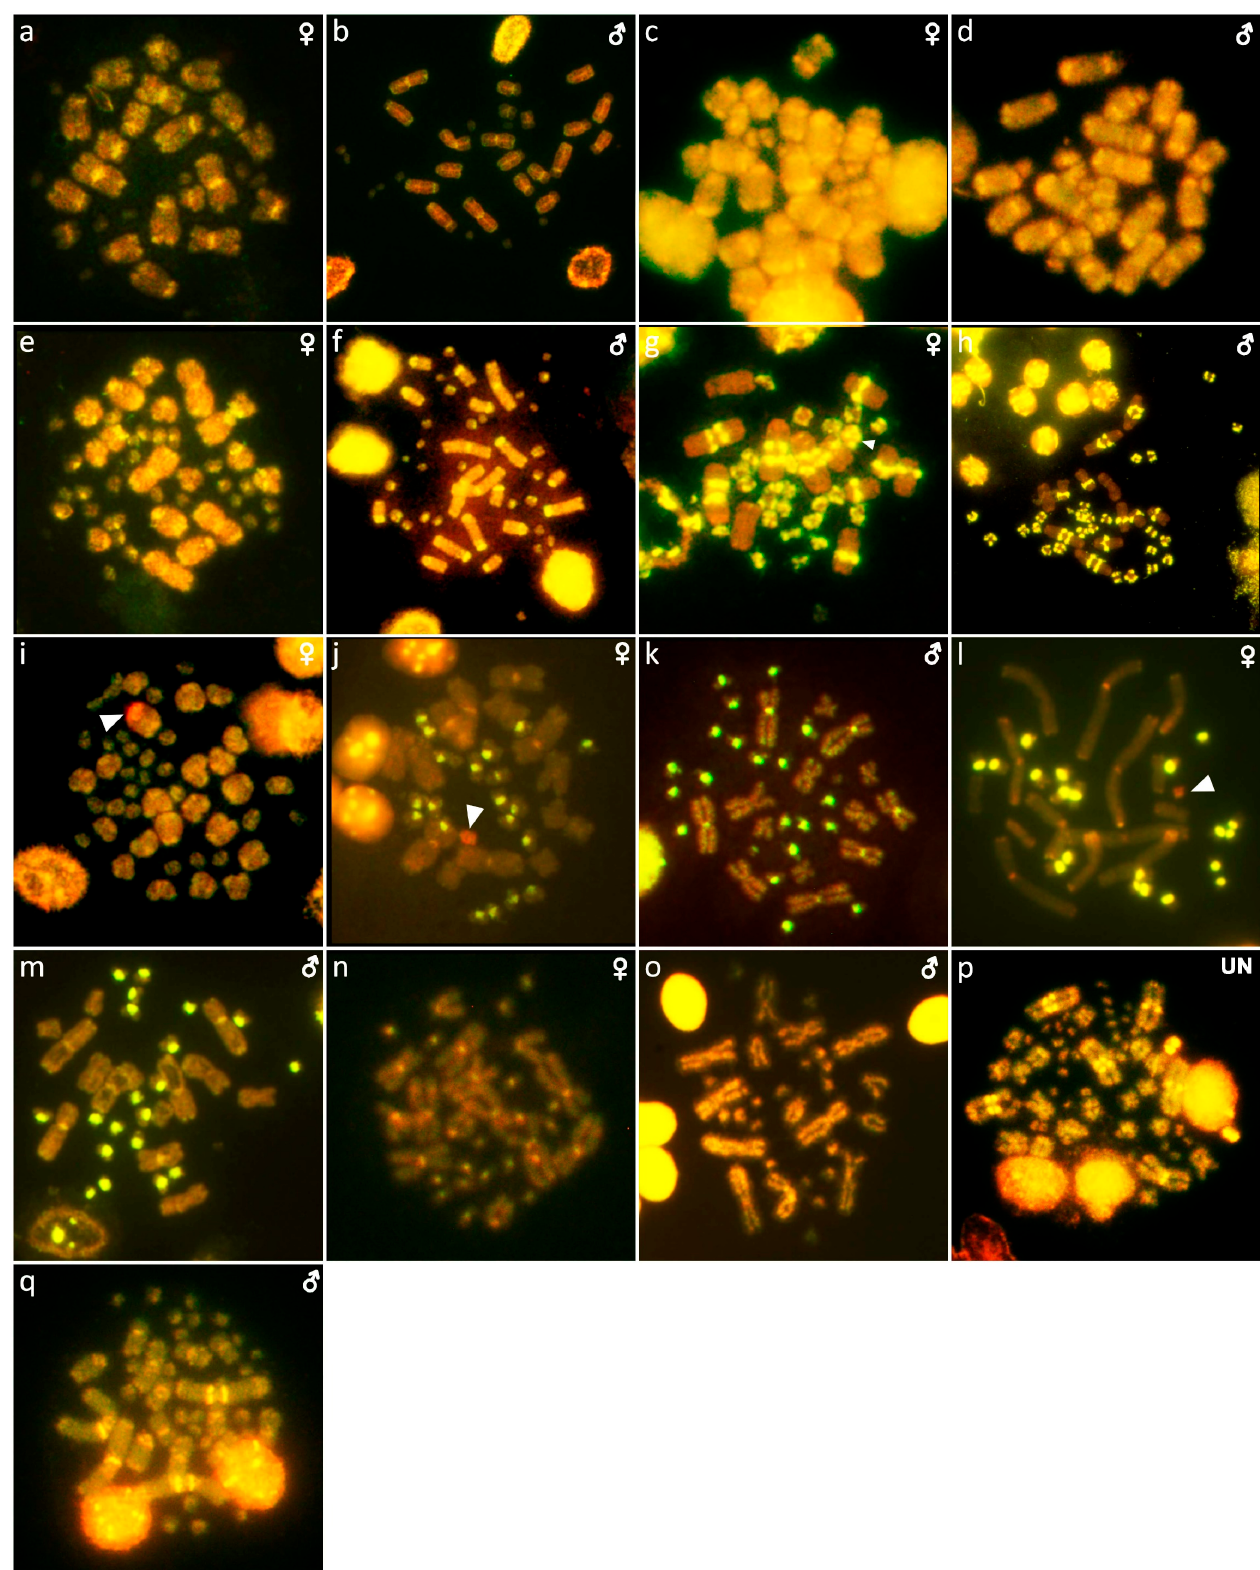
Figure 10. Comparative genome hybridization in Abronia deppii ( a , b ), Abronia lythrochila ( c , d ), Barisia rudicollis ( e , f ), Celestus warreni ( g , h ), Gerrhonotus liocephalus ( i ), Heloderma exasperatum ( j , k ), Heloderma horridum ( l , m ), Shinisaurus crocodilurus ( n , o ) and Varanus primordius ( p , q ). When visible, the W chromosomes are indicated by arrows. UN: sex not known.